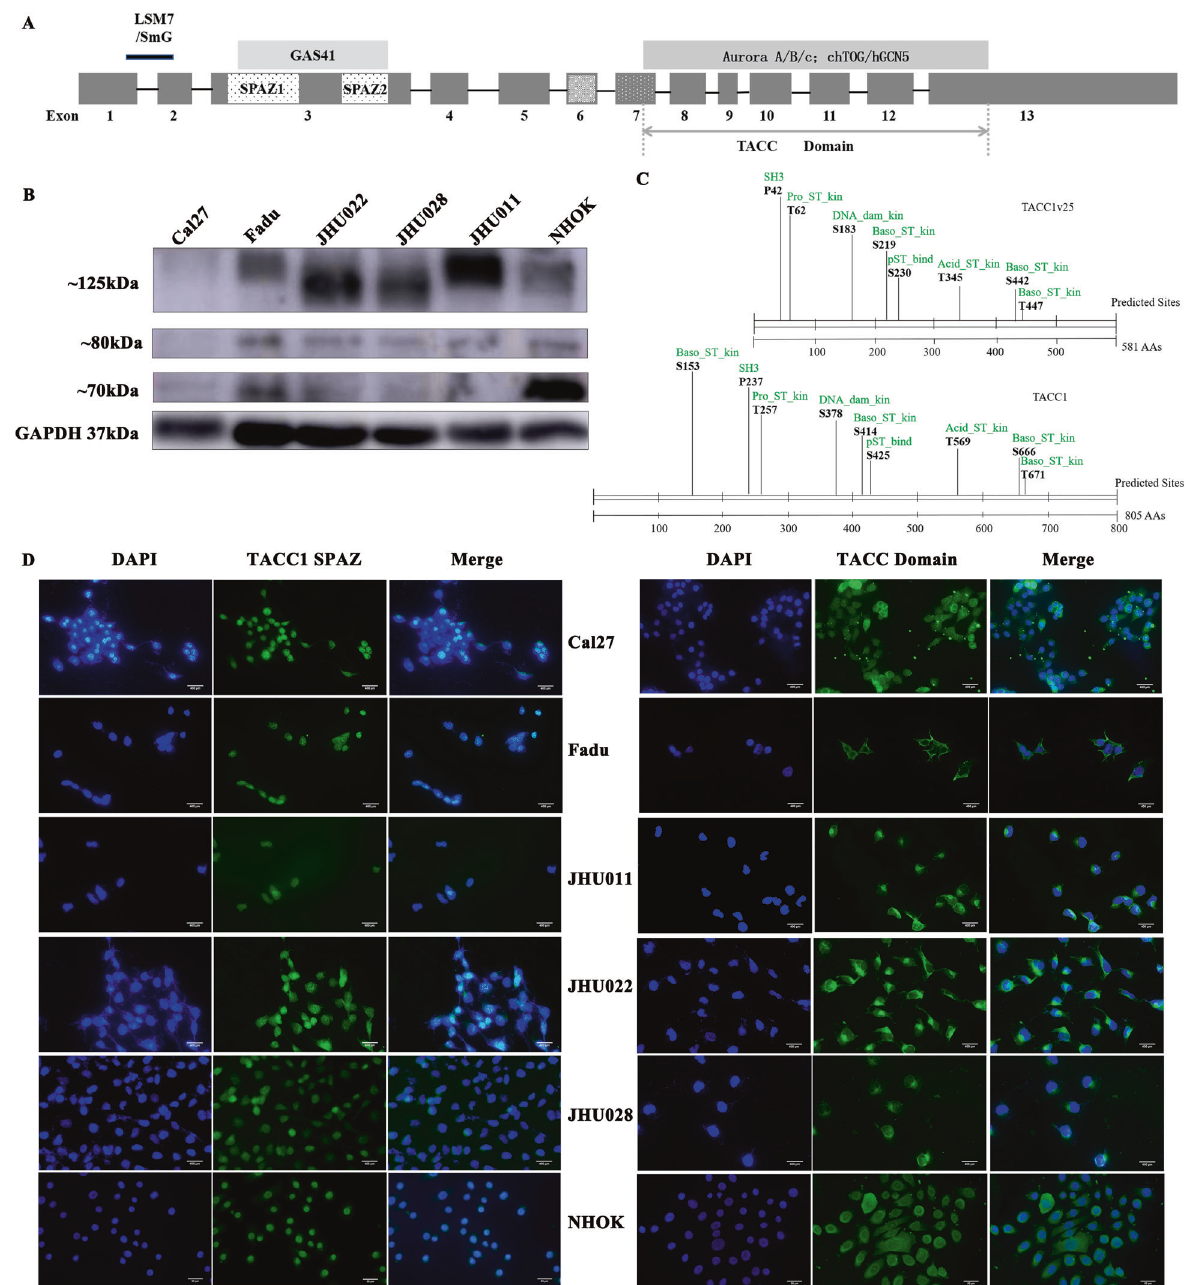
Fig. 2 Expression of endogenous TACC1 protein in HNSCC. A Schematic representation of TACC1 domains. This schematic diagram shows published TACC domain. B Western blot analysis. Because the anti-TACC1 domain antibody identi fi es all TACC1 variants proteins, stronger bands at ~70 and ~80 kDa in NHOK were TACC1v25 and/or 27 combined with RT-PCR. C Scansite analysis. Phosphorylation sites were predicted in TACC1v25 and full-length TACC1. The black words represent the possible phosphorylation site, while the green words represent the kinase or possible binding structure domain. D Immuno fl uorescence analysis. TACC1 variants include SPAZ domain encoding proteins that are primarily expressed in nucleus and perinucleus; however, TACC1 variants encoding protein containing TACC domains express in the nucleus, perinuclear region and cytoplasm. There was no signi fi cant difference of expression among the